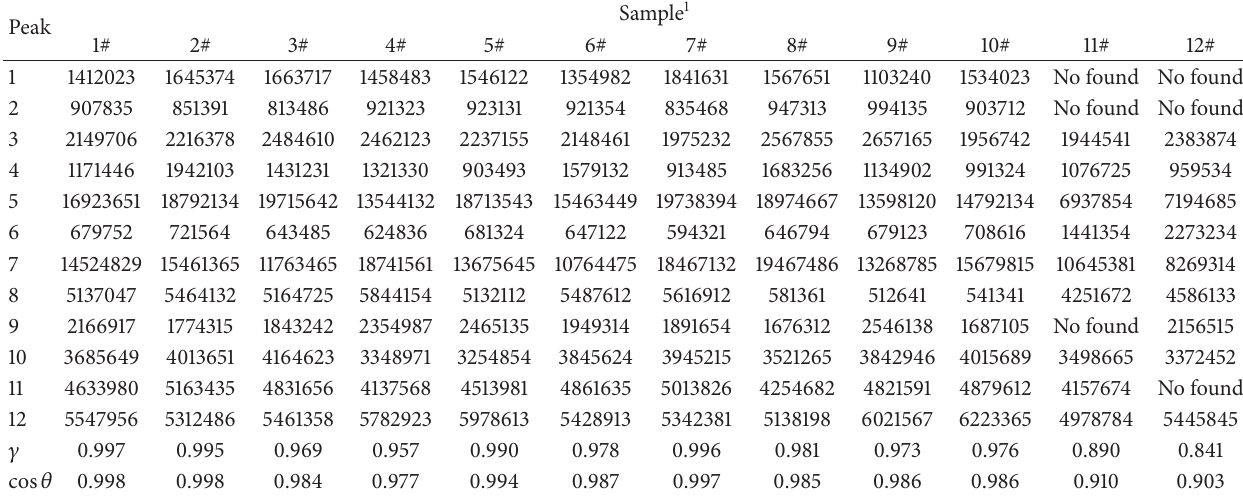
Table 3: Peak area of various samples analyzed by CE with carbon